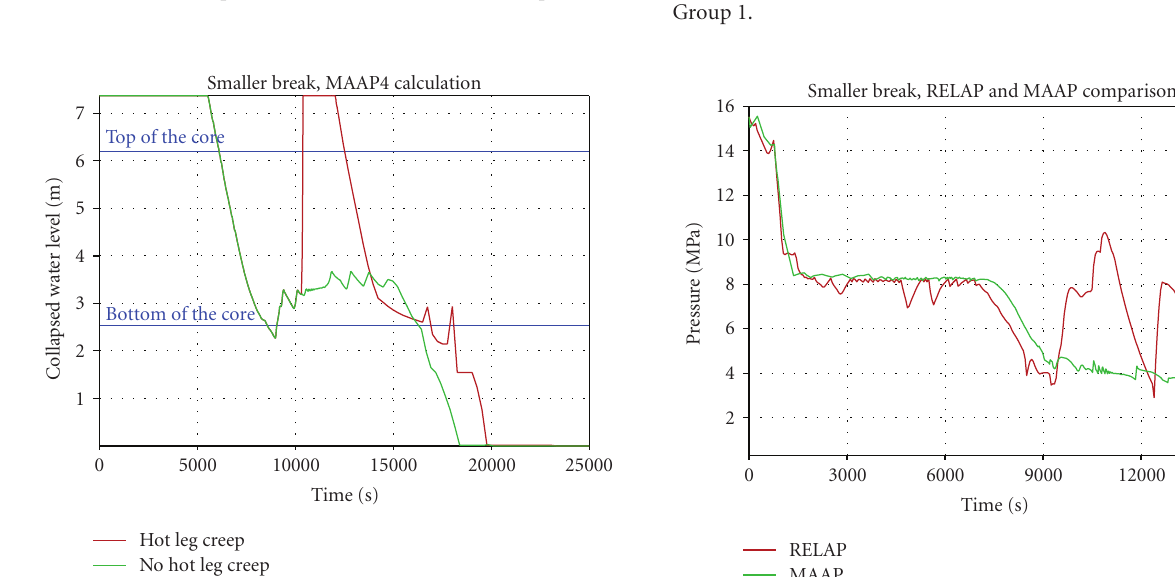
Figure 4: RCS pressure, MAAP4 calculation, Group 1.